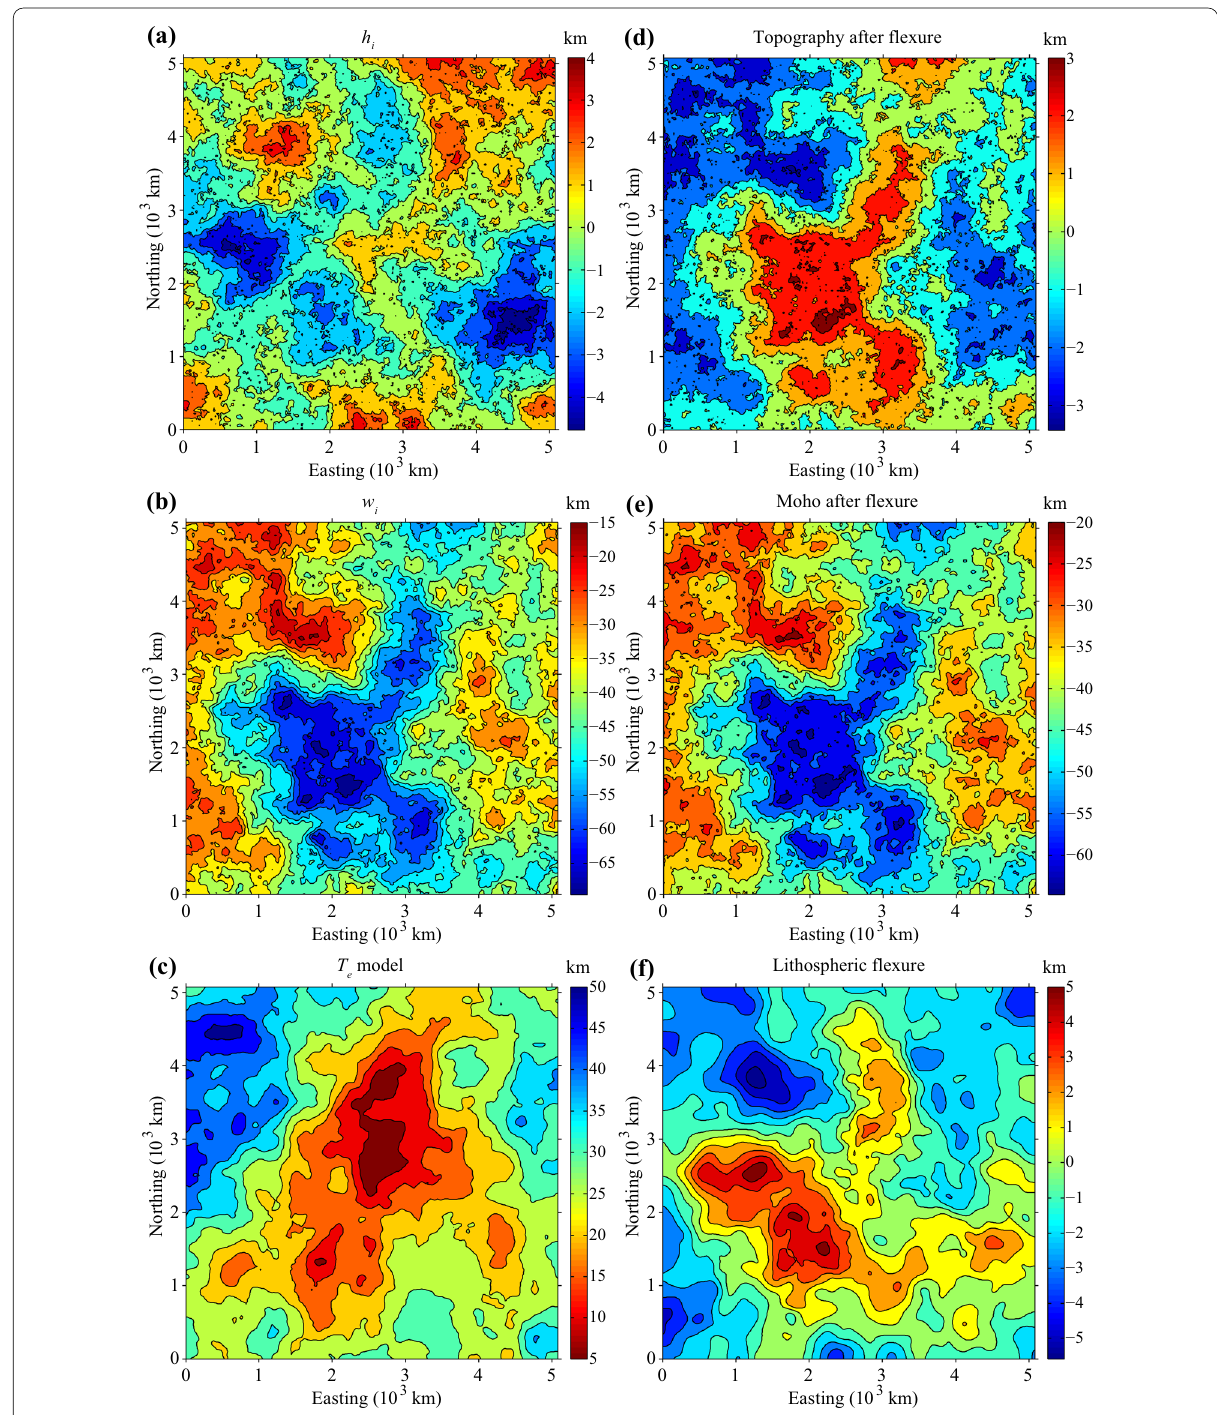
Fig. 2 a Initial surface ( h i ), b initial subsurface ( w i ), c T e model, d topography after flexure, e Moho after flexure, and f lithosphere